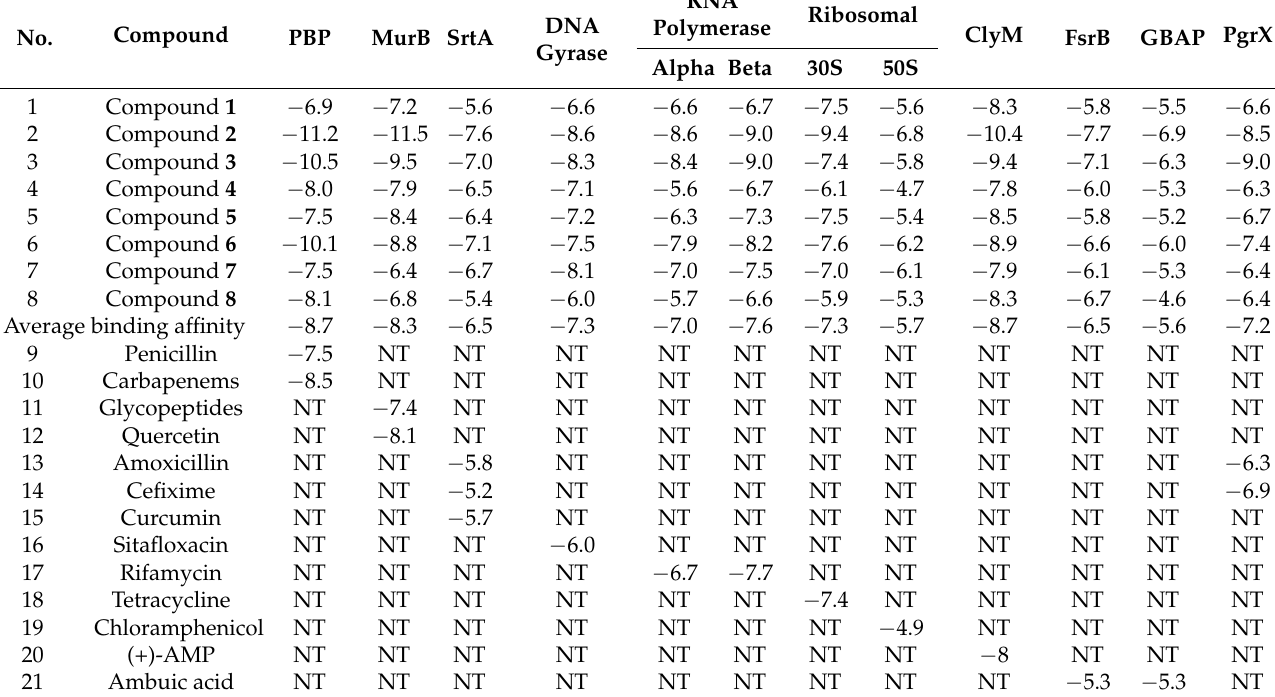
Table 3. Binding affinity of the compound against proteins (kcal · mol − 1